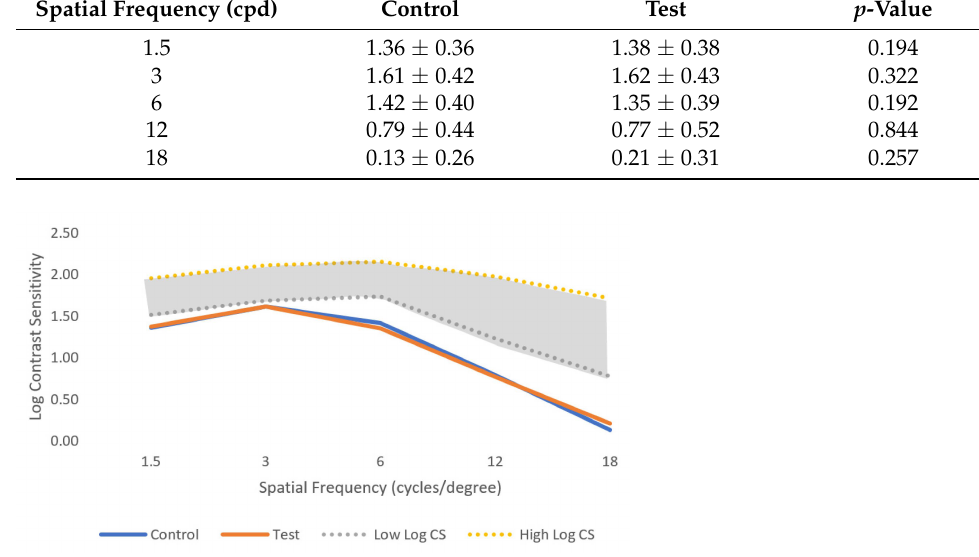
Figure 6. Mean of log visual contrast sensitivity for control and test conditions for the five spatial frequencies evaluated under low light conditions. The shaded area represents the normal ranges under photopic conditions for comparison. Standard deviation is not shown for clarity and can be consulted in Table